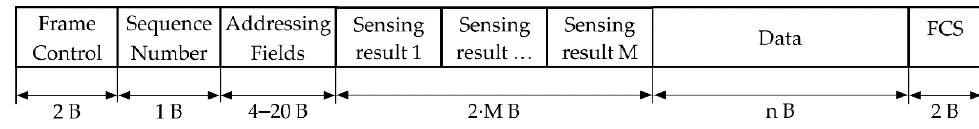
Figure 9. Sensing frame format.